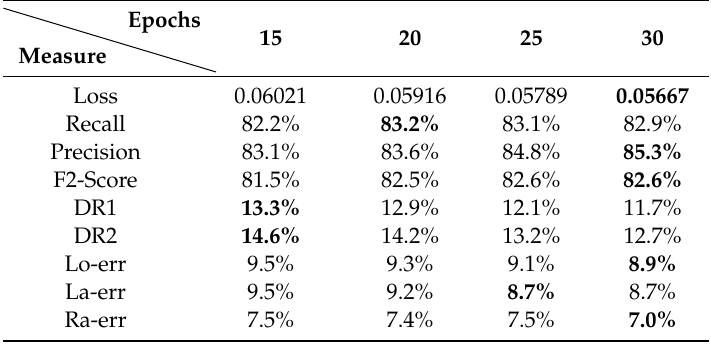
Table 5. The recognition result between 15 and 30 training time (bold in the table means the best results on this evaluation